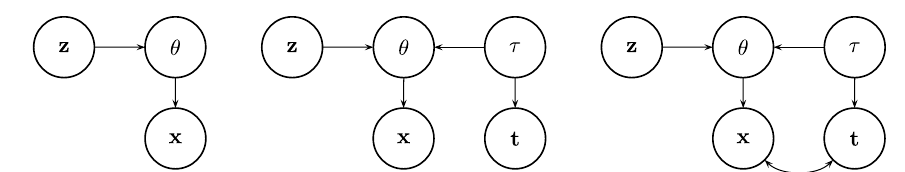
Fig. 2 IRT-LRMs: M3 (left), M4 (middle), and M5